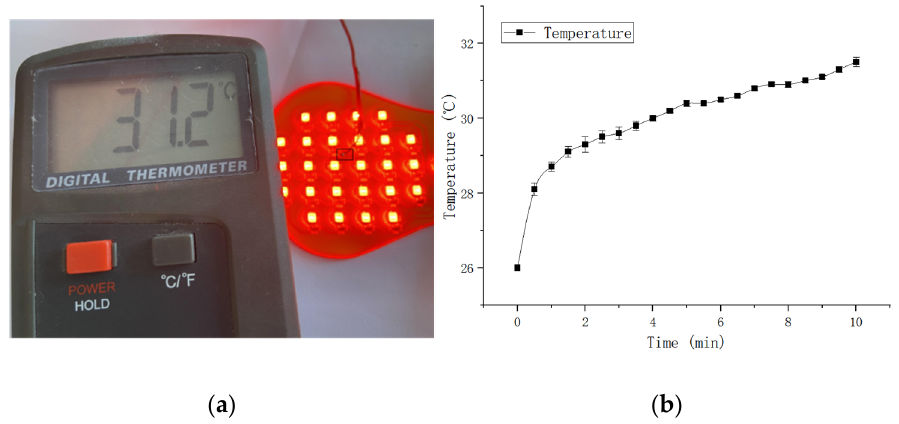
Figure 9. ( a ) Physical photo of temperature testing; ( b ) Temperature versus time curve.